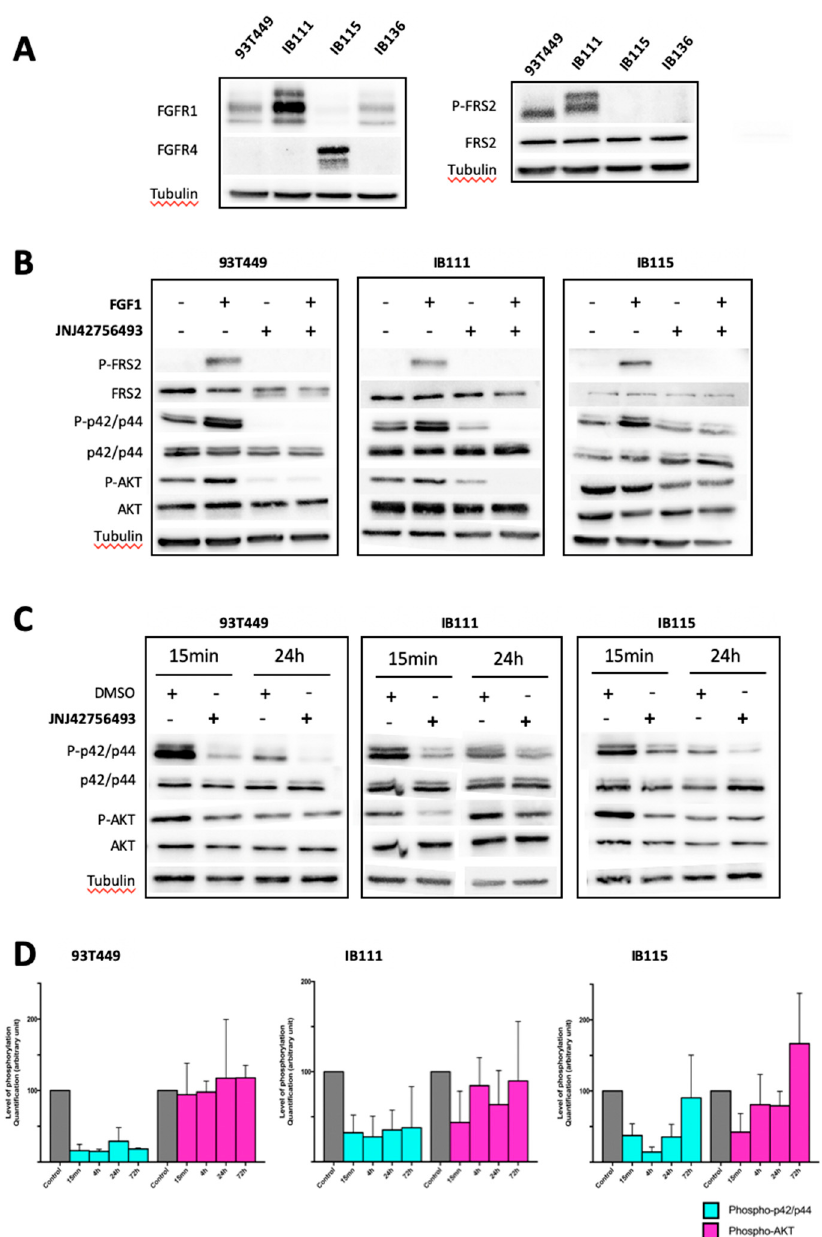
Figure 2. Analysis of the FGFR / FRS2 signaling pathway after FGFR stimulation and inhibition in WDLPS and DDLPS cell lines. Western blot analysis showing ( A ) The level of expression for the indicated proteins in one WDLPS (93T449) and two DDLPS (IB111 and IB115) cell lines was compared to the level of expression for the same proteins in a soft tissue leiomyosarcoma cell line (IB136) used as a negative control (non-adipose soft tissue sarcoma). ( B ) The level of phosphorylated and total protein for the indicated proteins in 93T449, IB111 and IB115 cells treated for 30 min with JNJ42756493 at the IC50 concentrations: 0.36 µ M (93T449), 1 µ M (IB111), and 2 µ M (IB115), with or without FGF1 stimulation (10 ng / mL for 15 min) as indicated. ( C ) The level of phosphorylated and total protein for the indicated proteins in 93T449, IB111 and IB115 cells treated for 15 min and 24 h with JNJ42756493 at the IC50 concentrations: 0.36 µ M (93T449), 1 µ M (IB111), and 2 µ M (IB115). In all Western blot experiments, β -tubulin was used as a loading control. ( D ) Quantification of the Western blot analyses shown in ( C ) performed on cells treated with JNJ42756493 for 15 min, 4 h, 24 h, and 72